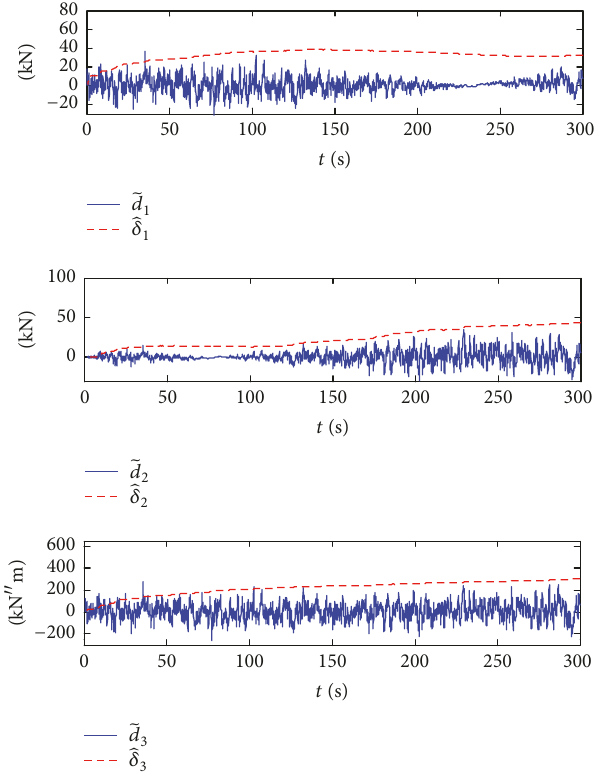
̃ d and their upper